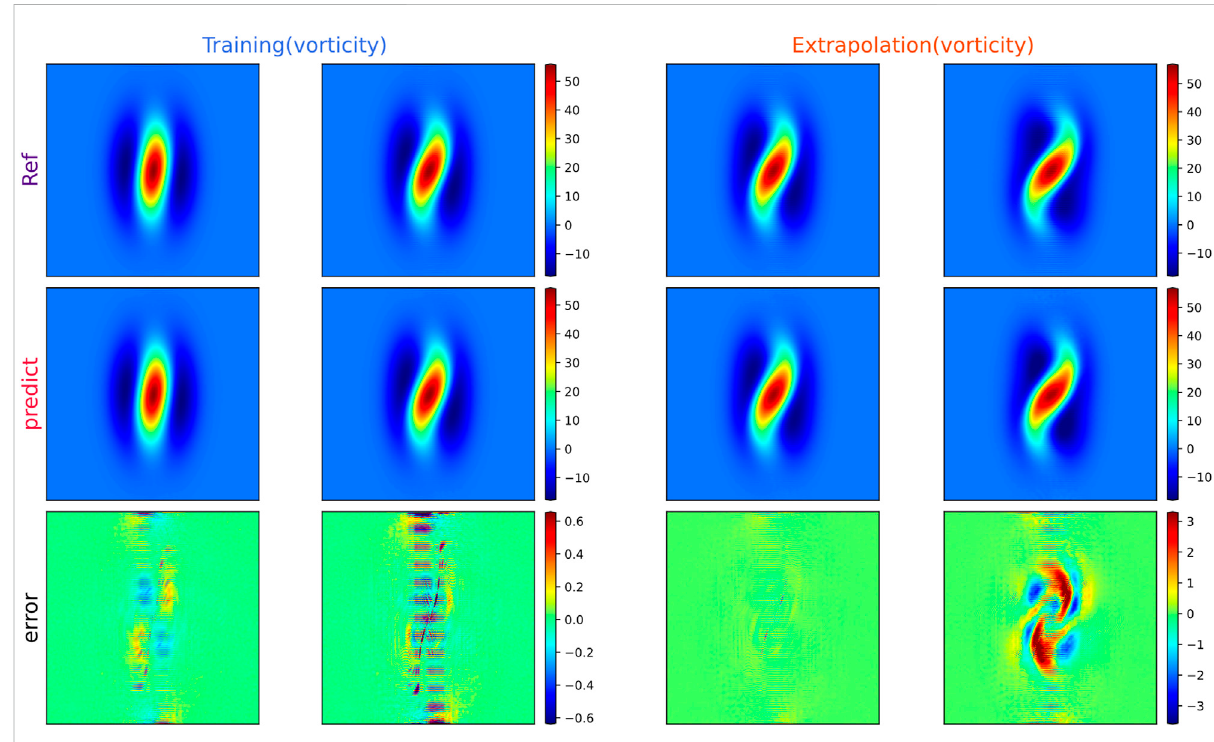
The vortex results for solving the vorticity equation with Fourier fi lter-based PhyCRNet. Four representative moments are selected for comparison, presenting thetraining (t = 0.025, 0.075 s) and extrapolation(t = 0.125, 0.175 s) maps, and compare the errors across the interval. From top to bottom are reference solutions, predictions and errors.